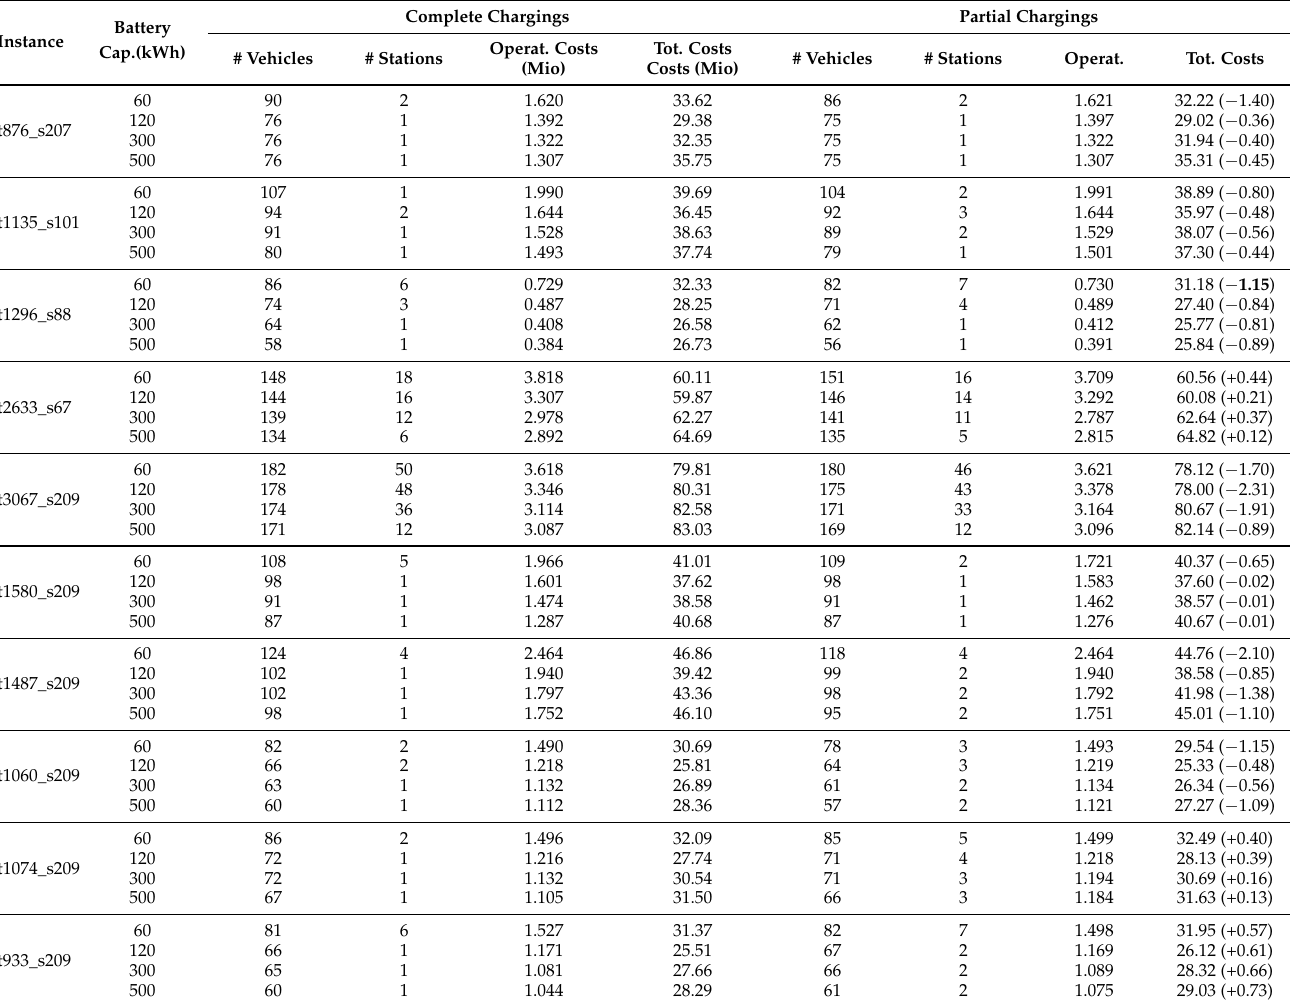
Table 4. Results of Algorithm 2 for generating initial vehicle rotations for electric buses and locations for charging stations considering complete and partial charging